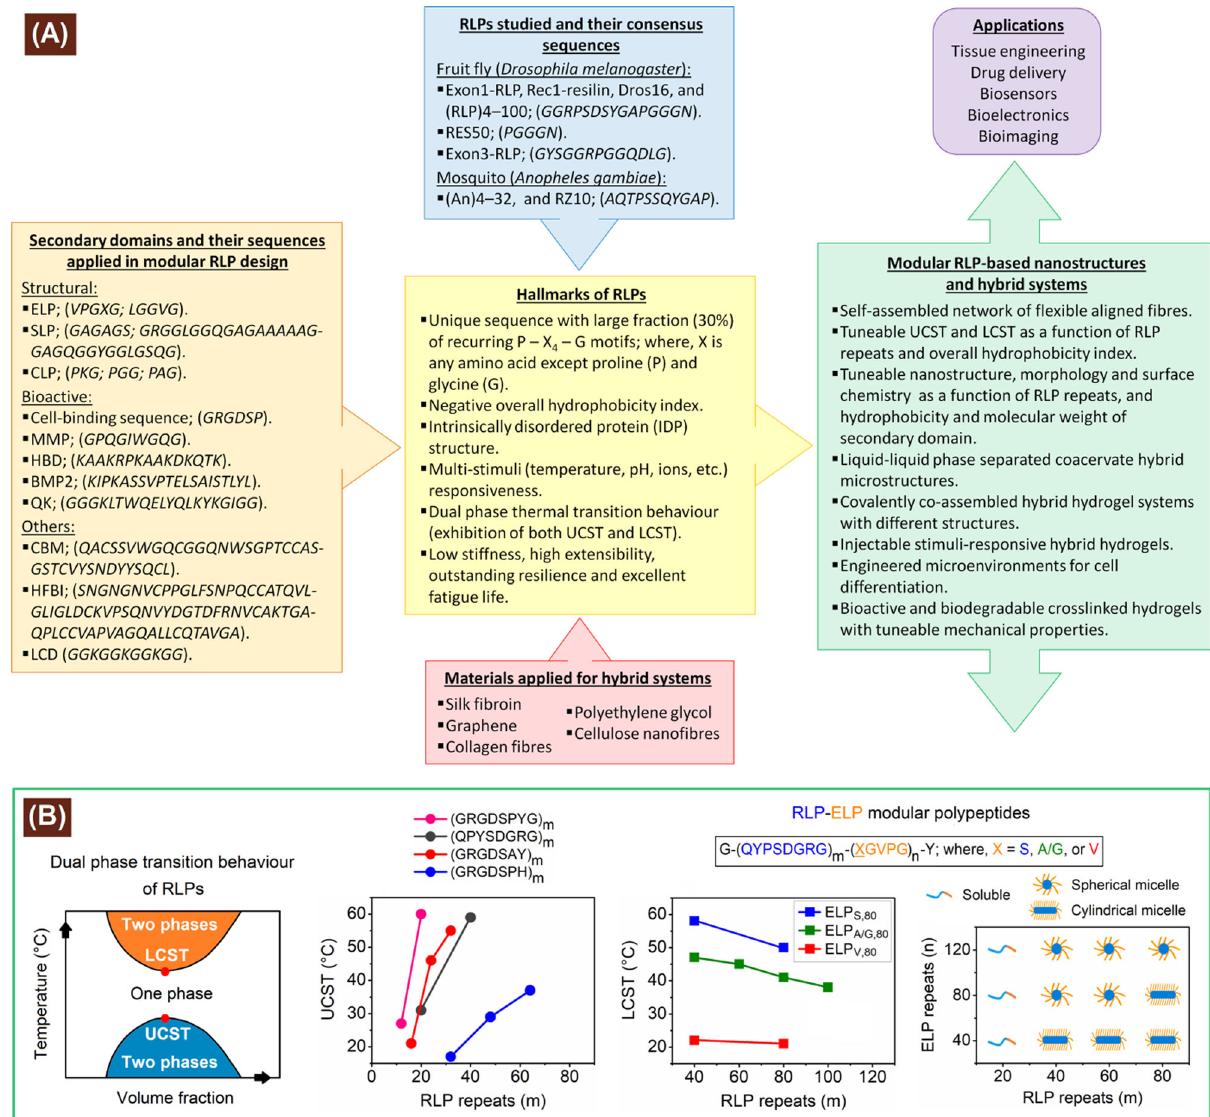
Fig. 4 Hallmarks of RLPs, development of modular RLP-based materials and their structure – property relationship. a Summary of RLPs, secondary domains and other materials applied for development of modular RLP-based nanostructures and hybrids. The amino acid sequences of RLP repeats and secondary domains are presented as a single letter code. UCST upper critical solution temperature, LCST lower critical solution temperature, ELP